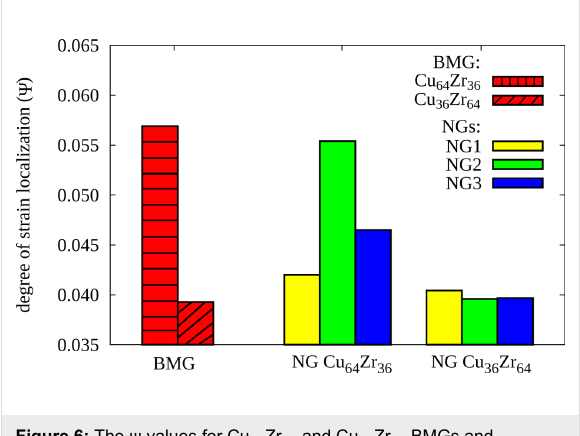
Figure 6: The ψ values for Cu 64 Zr 36 and Cu 36 Zr 64 BMGs and as-prepared (NG1), annealed (NG2), annealed and pre-deformed (NG3) NGs after plastic deformation to an overall strain of 16%.